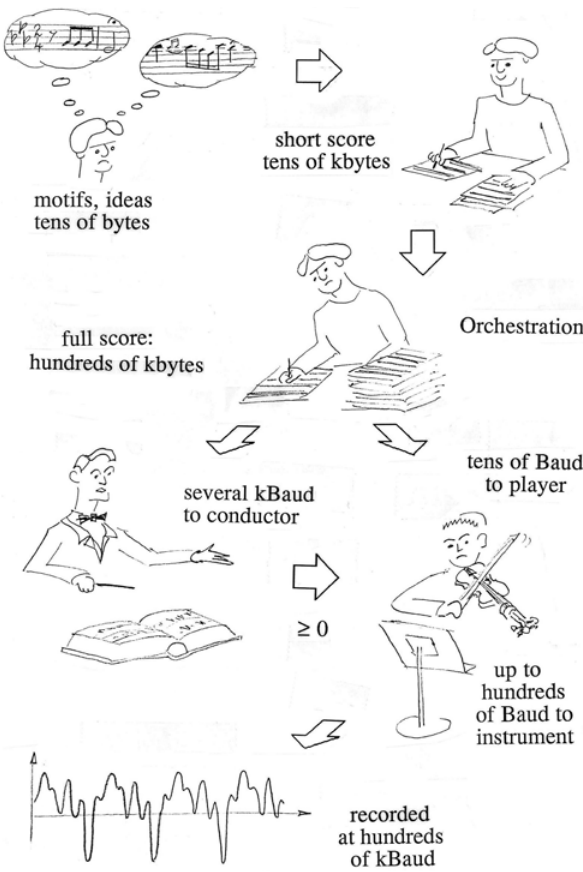
Figure 3. One information chain, from composer’s original ideas to performed music. The approximate data content is given in bits and kilobytes (1 kbyte ≅ 8000 bits) and the rate of data transfer is given in Baud (1 Baud = 1 bit per second) and